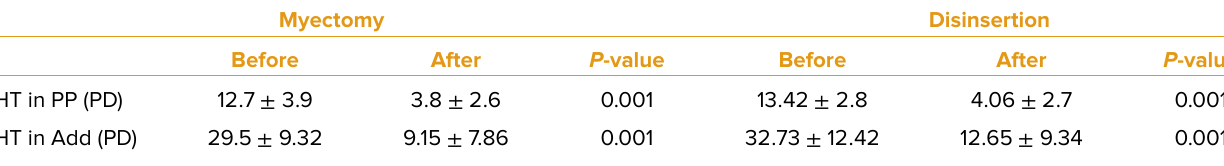
Table 3. Amount of hypertropia in the primary position and adduction before and after the surgery in the unilateral cases Myectomy Disinsertion Before After P -value Before After